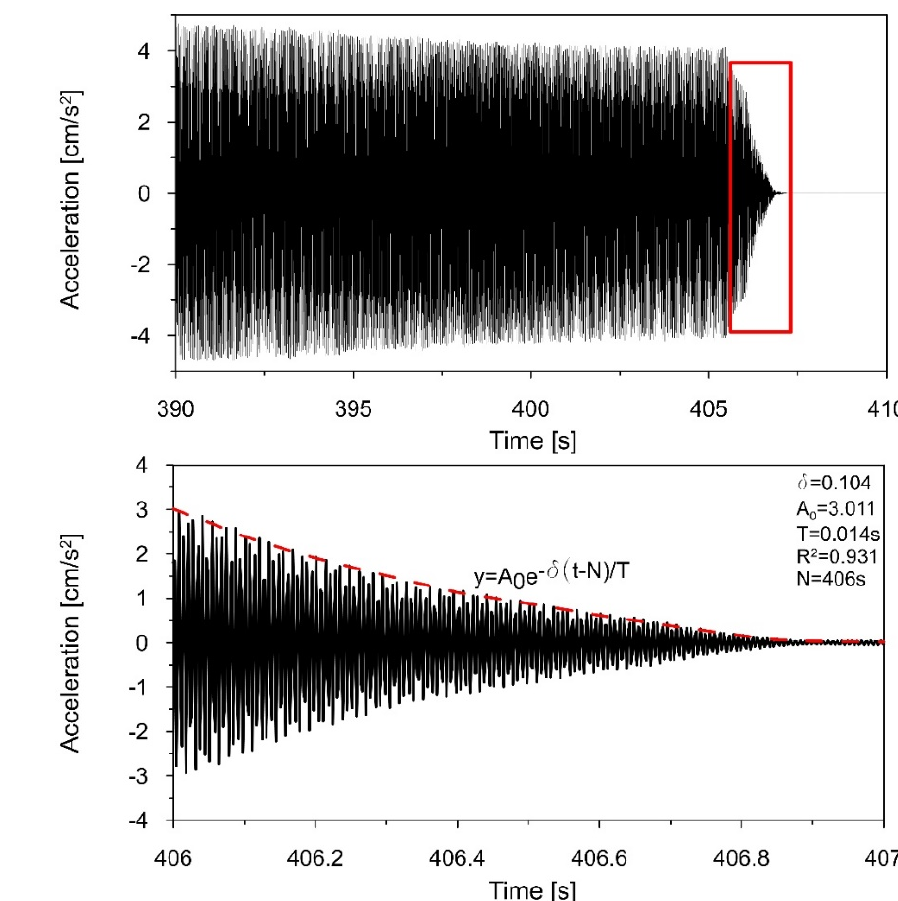
Figure 18. ( a ) The acceleration − time history filtered around f 2 = 73.263 Hz, ( b ) the decrease in the amplitudes (406–407 s) that served to estimate the logarithmic decrement of damping δ 2 = 0.104.